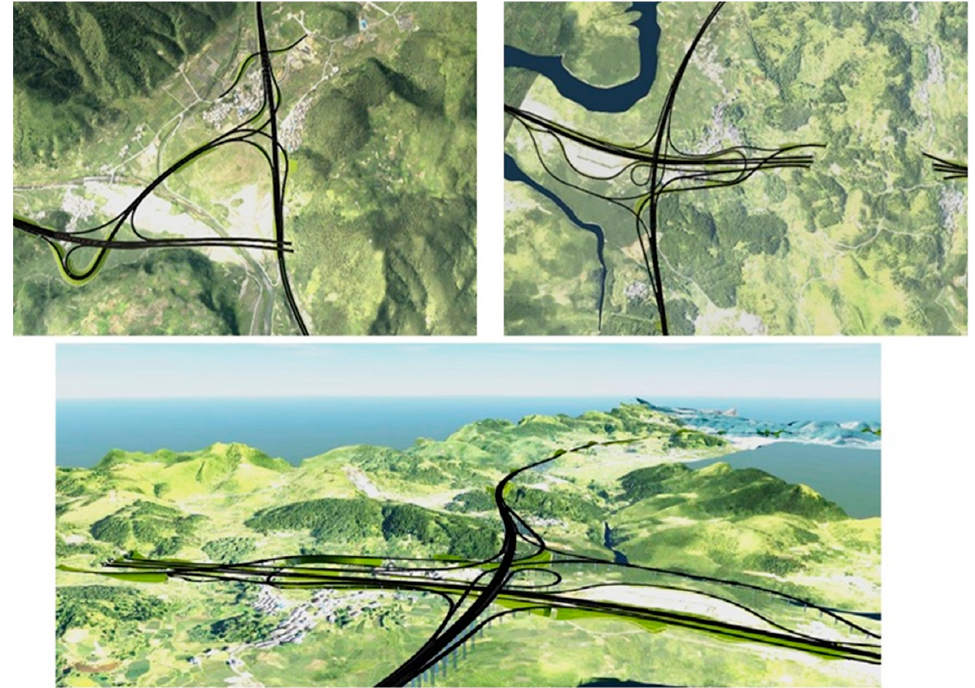
Figure 10. Three-dimensional (3D) model of DuAn highway with its surroundings.